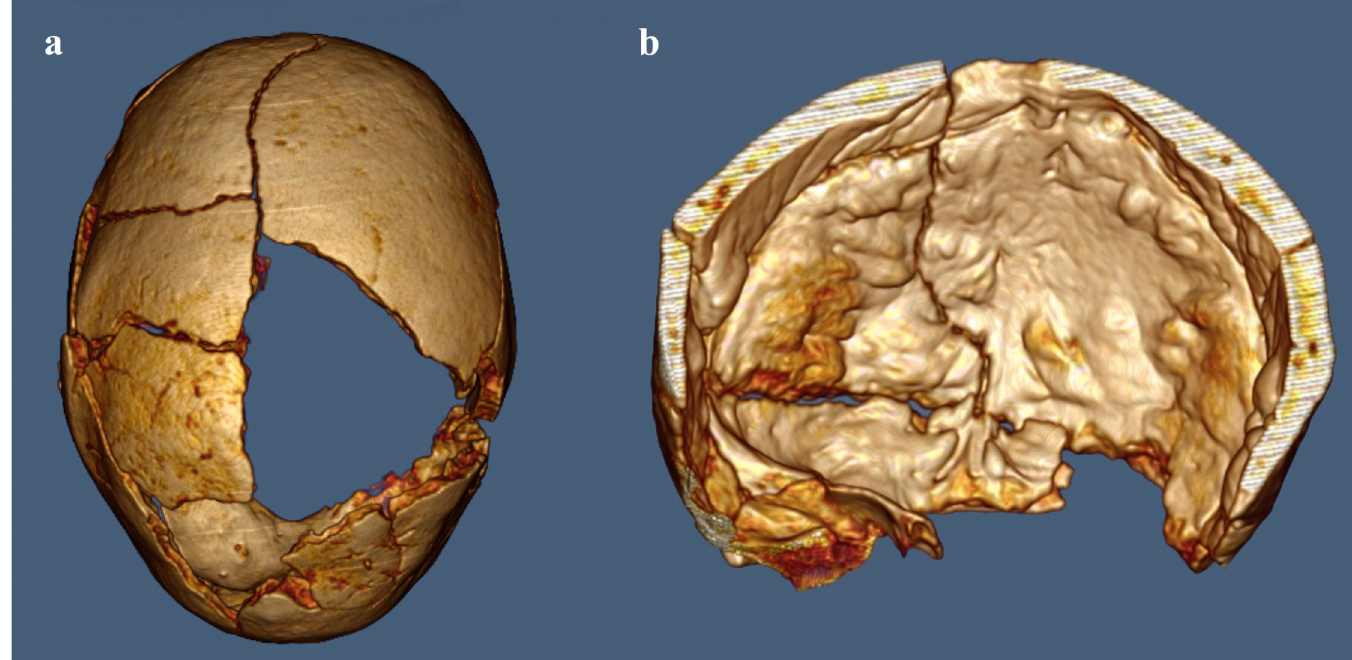
Fig 8. 3D virtual reconstruction: a. superior view of the restored skull; b. coronal section of the frontal bone with the software OsiriX Lite .